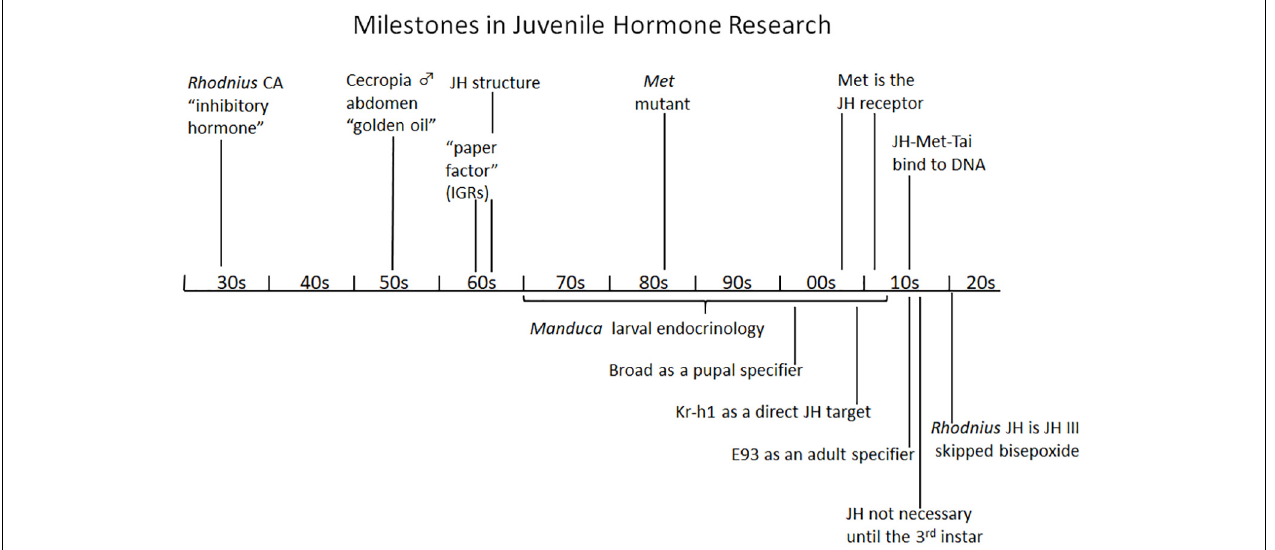
FIGURE 7 | Summary diagram of milestones in juvenile hormone research. See text for details. CA, corpus allatum; IGR, insect growth regulator; JH, juvenile hormone; Kr-h1, Krüppel homolog 1; Met, Methoprene-tolerant ; Tai, Taiman.